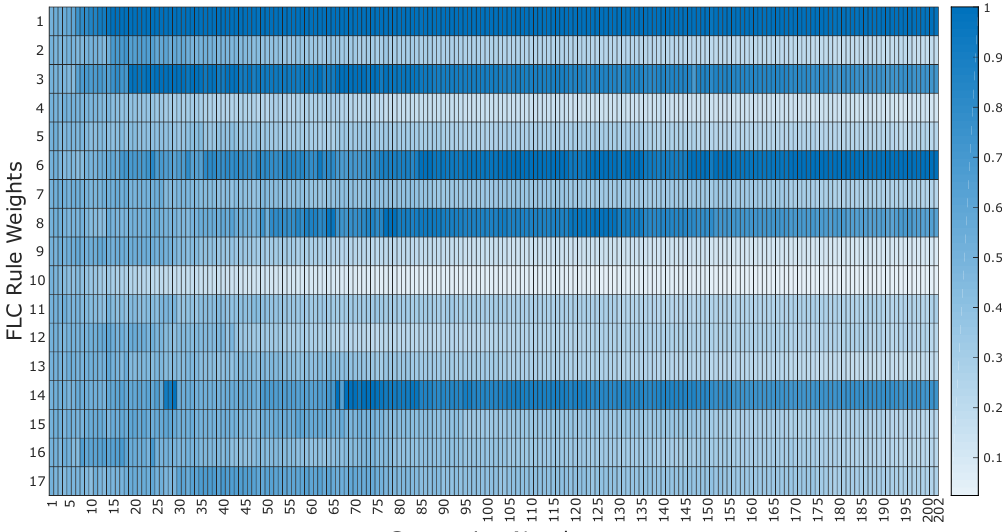
Figure 12. Heat map of the best individual for all FLC rule weights for each